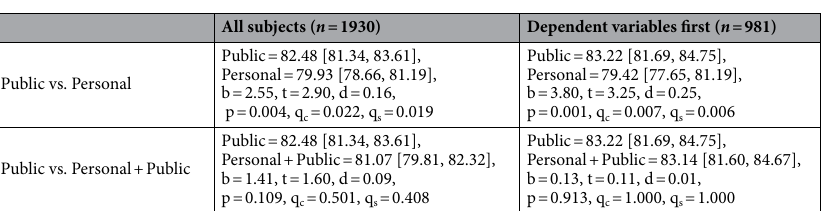
Figure 2. Prevention intentions by experimental condition in Study 1. Shown are frequencies of composite prevention intentions, rounded to zero or a multiple of ten, by experimental condition in Study 1, among all subjects ( A , n = 988) and subjects for whom we measured our dependent variables first ( B , n = 506).